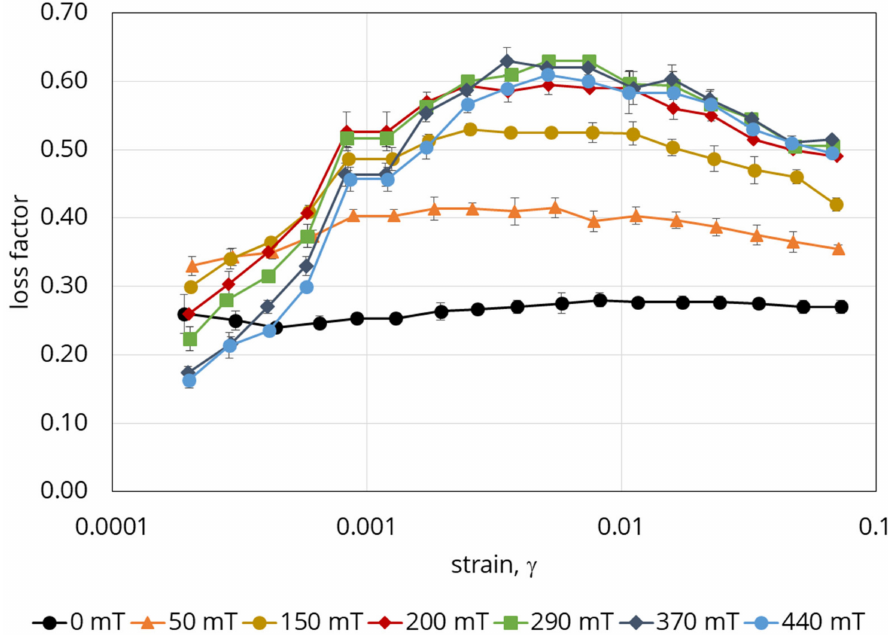
Figure 8. Dependence of the loss factor of the material on deformation (strain) and magnetic field for the Fe–Ni alloy-based